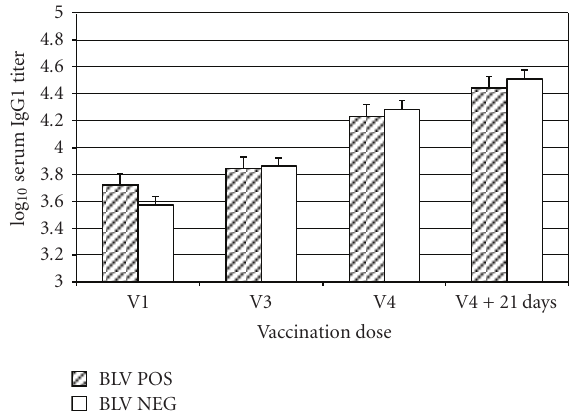
Figure 2: Mean ± SEM serum IgG1 titers in 22 BLV-positive cows (BLV POS) and 13 BLV-negative cows (BLV NEG) administered a J5 E. coli bacterin with 4 doses of bacterin administered SC in the left side of the neck (odd-numbered doses) or right side of the neck (even-numbered doses).Blood samples were collected from all cows at the time of the first (V1: approx 7 weeks before parturition), third (V3: second week after parturition (between days 8 and 14 after parturition)), fourth (V4: 5 weeks (between 29 and 35 days) after parturition) vaccinations, and 21 days after the fourth vaccination.